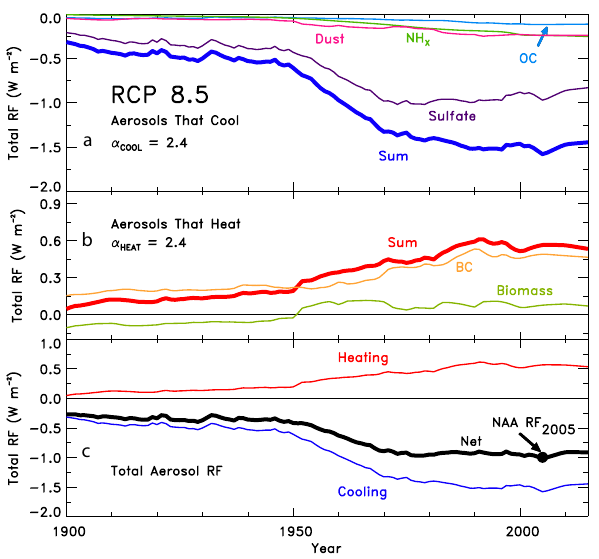
Fig. 3. (a) Total RF of tropospheric aerosols that cool, as labelled, based on our Smith* estimate of RF SULFATE − DIR and RCP 8.5 estimates of direct RF for other components, all multiplied by α COOL = 2 . 4. The curve labelled Sum denotes total RF due to aerosols that cool. (b) Same as (a) , except for aerosols that heat. Direct RF components, from RCP 8.5, have been multiplied by α HEAT = 2 . 4, chosen so that net anthropogenic aerosol RF (NAA RF) in year 2005 equals − 1 . 0Wm − 2 (IPCC, 2007). The curve la- belled Biomass refers to emissions of OC and BC due to biomass burning, and the curves labelled OC and BC refer to fossil fuel burn- ing emissions of these components. (c) total RF of aerosols that cool (blue, found for α COOL = 2 . 4), of aerosol that heat (red, found for α HEAT = 2 . 4), and their difference that defines NAA RF (black curve). The value of NAA RF in year 2005 is marked. It is coinci- dence that the two scaling parameters both require a value of 2.4 to match IPCC (2007) estimates of RF SULFATE − DIR and NAA RF in year 2005. Model results are shown for a variety of values of α COOL and α HEAT .